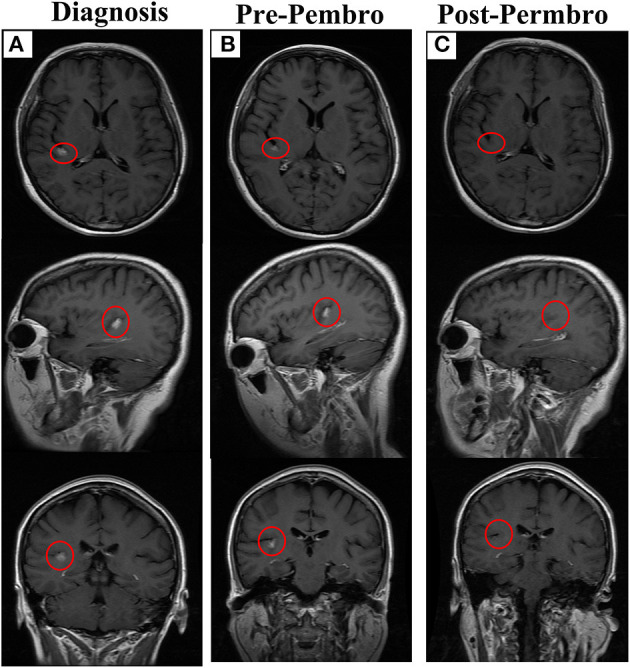
The outcome of letrozole combined with pembrolizumab. (A) The brain lesion in diagnosis, lesion has been marked with red circle. (B) The brain lesion before treatment with letrozole combined with pembrolizumab. (C) Disappearance of brain lesion after treatment. Permbro, pembrolizumab.